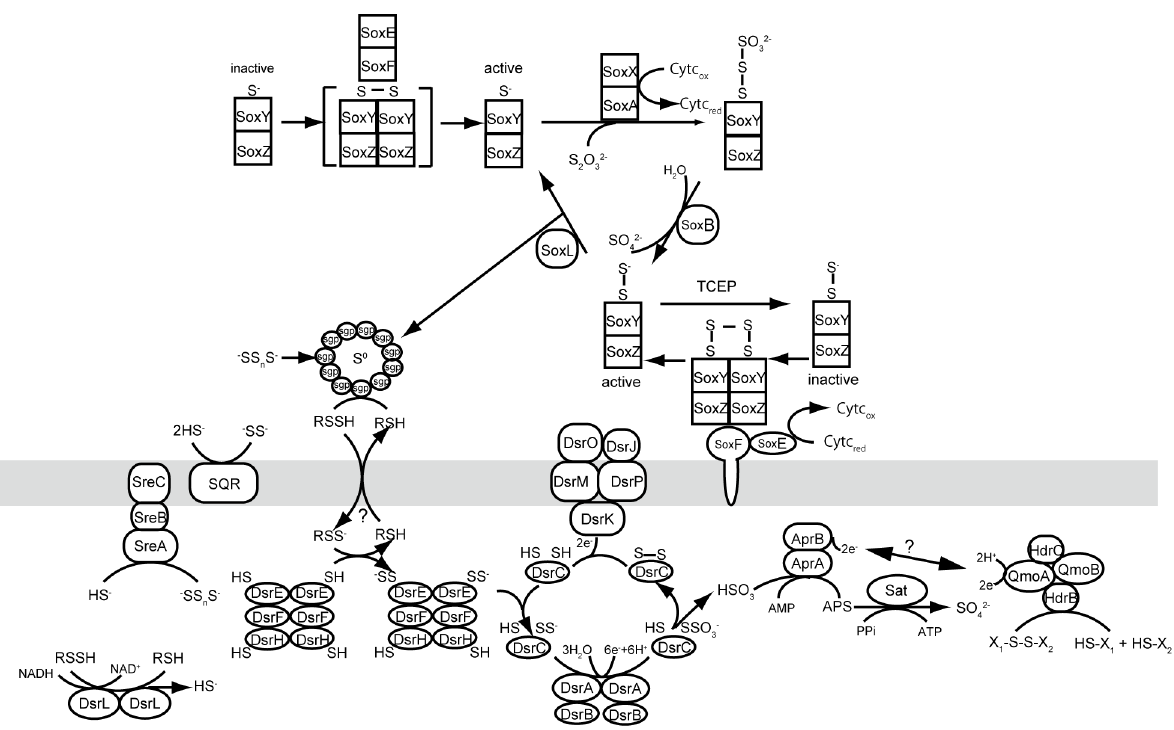
Figure 4. Predicted sulfur oxidation pathways of strain Hiromi 1 inferred from the previously published literatures [63,66–68,74,75] . TCEP; tris(2-carboxyethyl)phosphine.